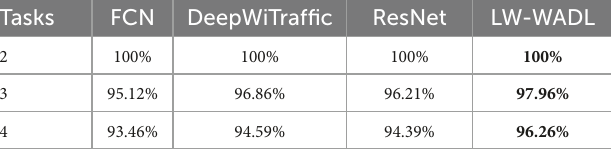
Frontiers in Neuroscience